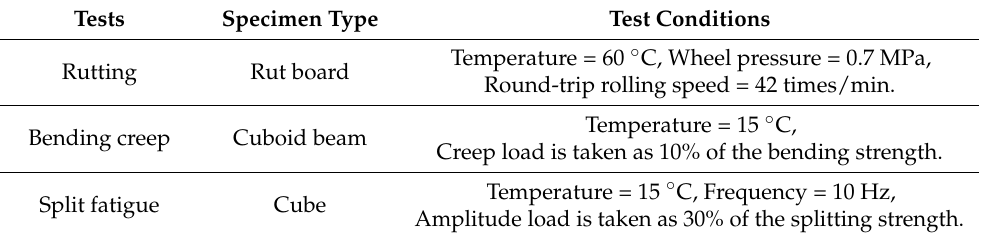
Table 4. Experimental program.